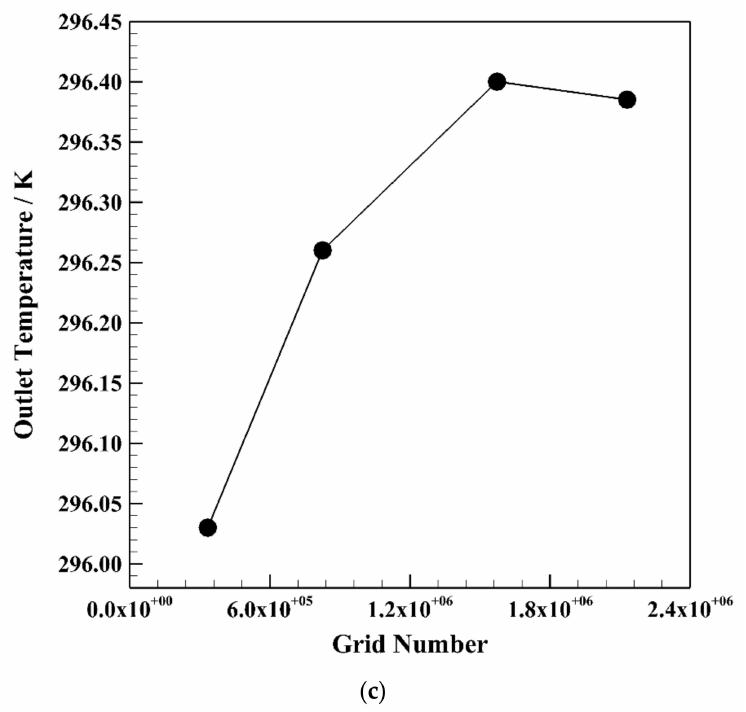
Figure 2. Generated grid for the BHE and the grid independence test: ( a ) 3D view, ( b ) 2D view, and ( c ) the grid independence test.